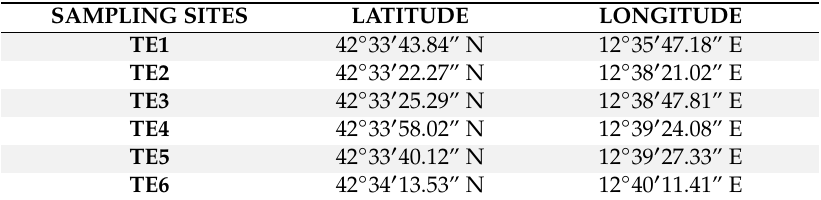
Figure 1. Sampling sites of A. donax leaves and river-water samples along the river Nera in Terni (Central Italy) and air-quality station “Prisciano” controlled by ARPA Umbria (regional agency for environmental protection): Highlighted are the main PM 10 anthropogenic emission sources present in the study area. Table 1. Latitude and longitude of the six sampling sites in Terni.